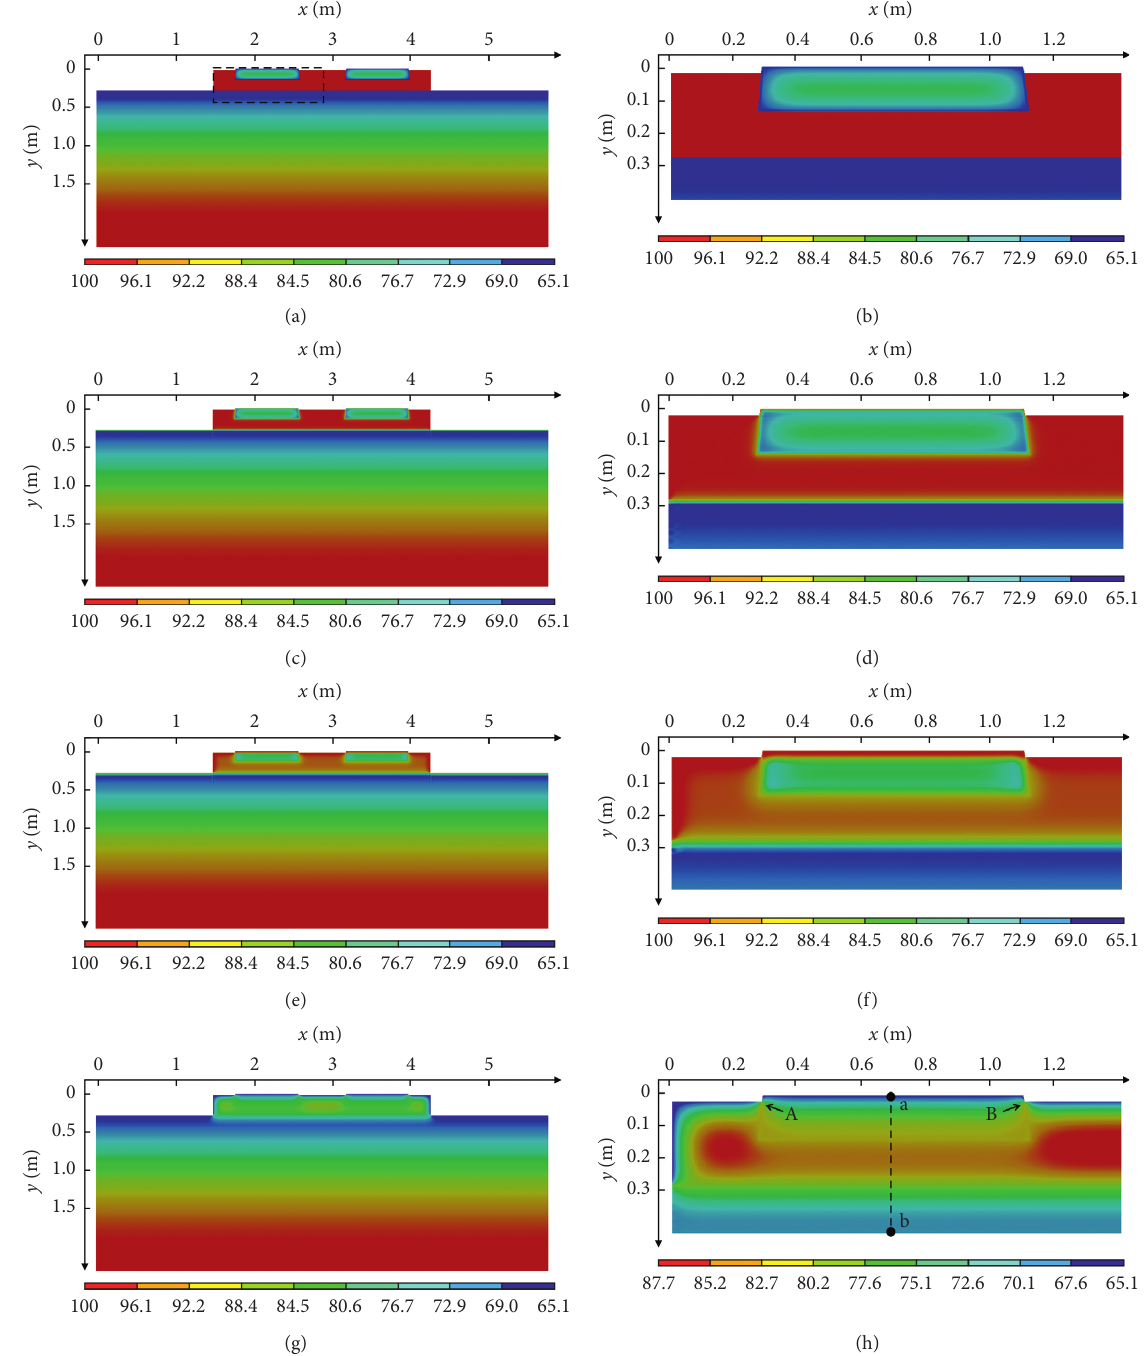
Figure 17: RHcontour of ballastless trackat differenttimes. (a) t � 0d, entire contour;(b) t � 0d, local contour;(c) t � 1d, entire contour;(d) t � 1d, local contour; (e) t � 7d, entire contour; (f) t � 7d, local contour; (g) t � 60d, entire contour; (h) t � 60d, local